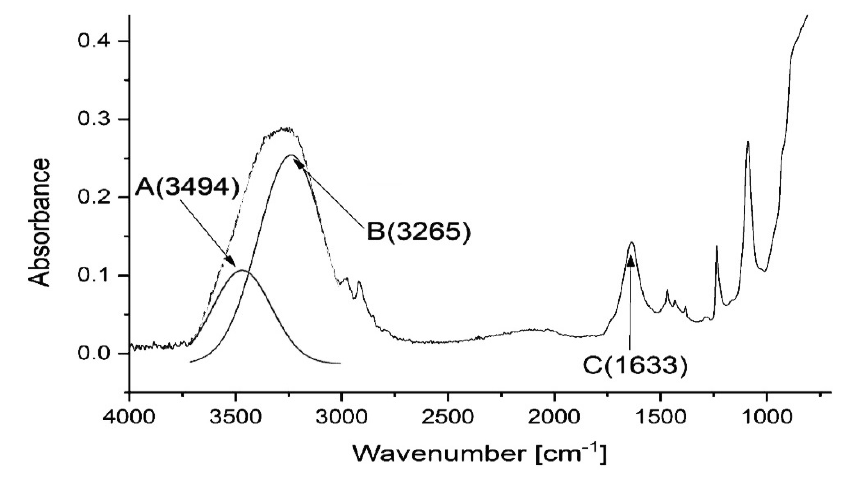
Figure 3. Notation of the bands taken under consideration in the Gaussian distribution of the ν OH band.